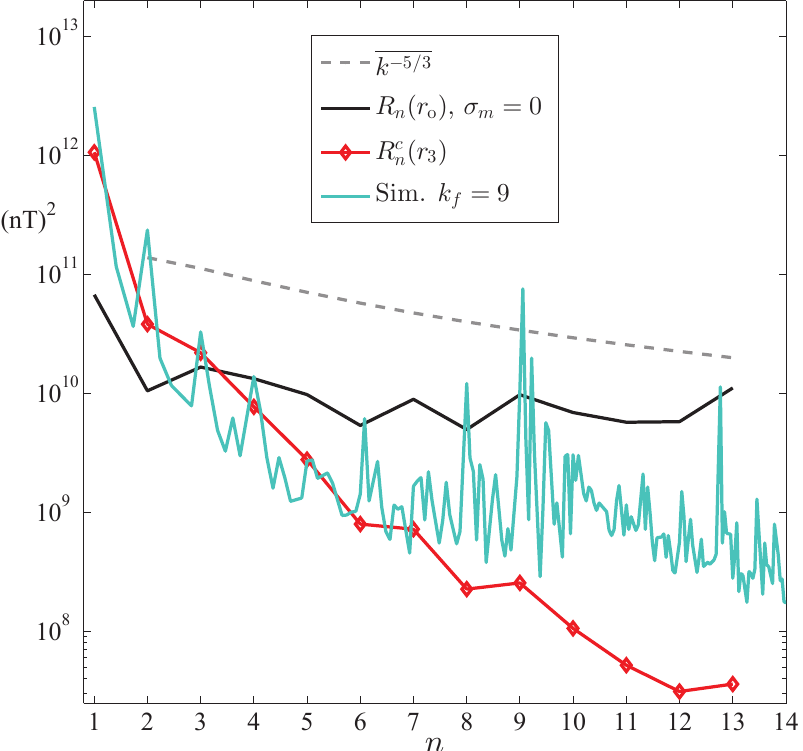
Figure 2. The spectrum R o n ( r 3 ) from Figure 1 along with a scaled, overlaid turbulent spectrum from simulation NM06 discussed in [26]; NM06 was forced at wavenumber k f = 9 (please see text for more details). The Mauersberger–Lowes spectrum R n ( r o ) on the CMB and a representative Kolmogorov spectrum k − 5/3 are also